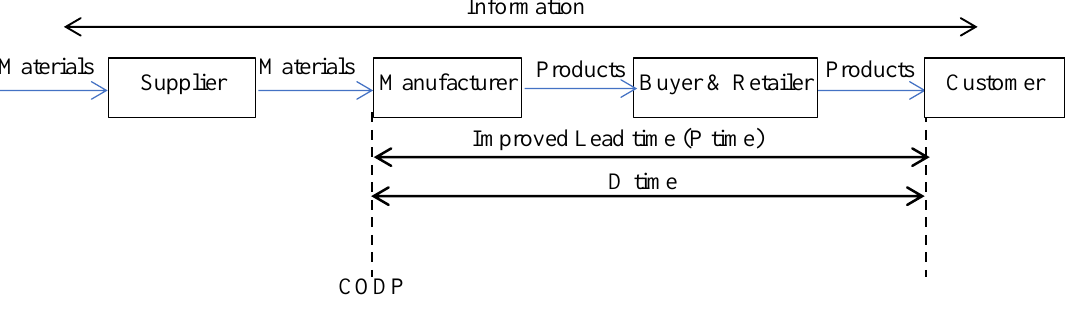
Figure 7. The modified supply chain structure of the current case study with the introduction of